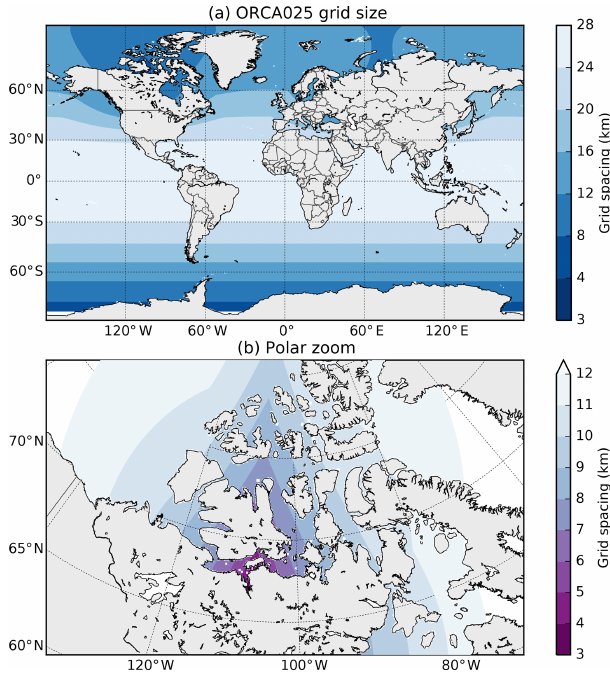
Figure 1. Grid size, defined as min ( e 1 t , e 2 t ) , on the ORCA025 grid. (a) In the global view, grid-point spacing gradually decreases from the Equator towards the north and south poles. (b) In a detail view of the north polar region, the grid is especially high resolution in the southern portion of the Canadian Arctic Archipelago, with grid-point spacing as low as